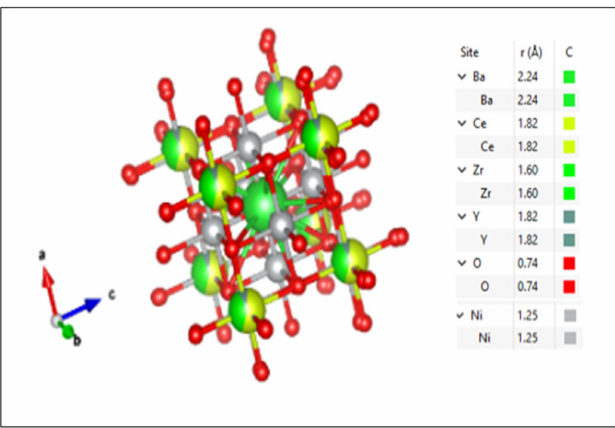
Figure 3. The crystal structure of NiO-BCZY.